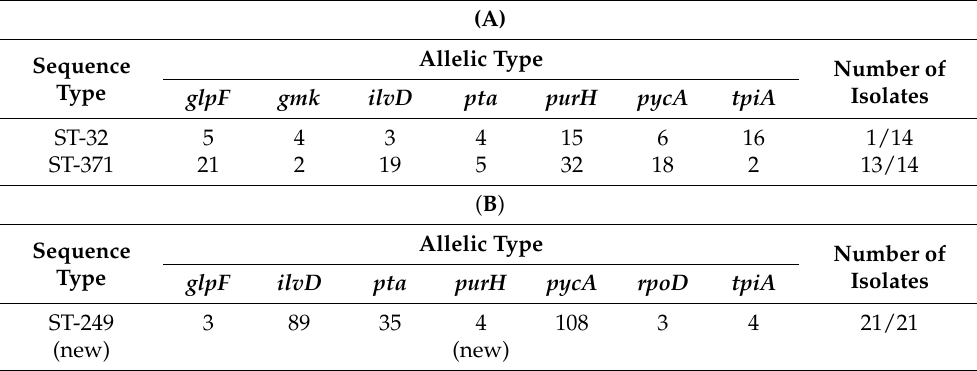
Table 2. MLST allelic profiles of isolated strains. ( A ) For Bacillus cereus 1 isolate (BC_2) showed ST-32, in the remaining 13 isolates the sequence type identified was ST-371. ( B ) All twenty-one Bacillus subtilis exhibited the same new sequence type (ST-249).